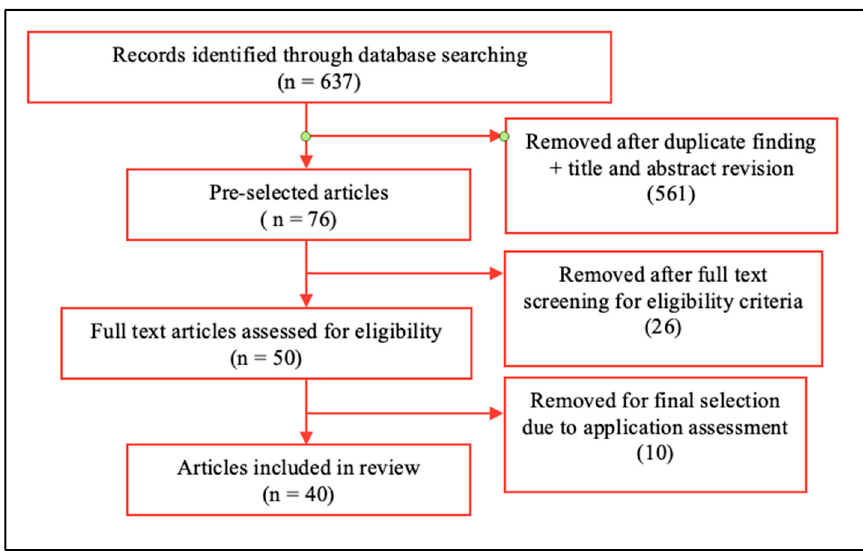
Figure 1. Deep analysis article selection process after database searching.